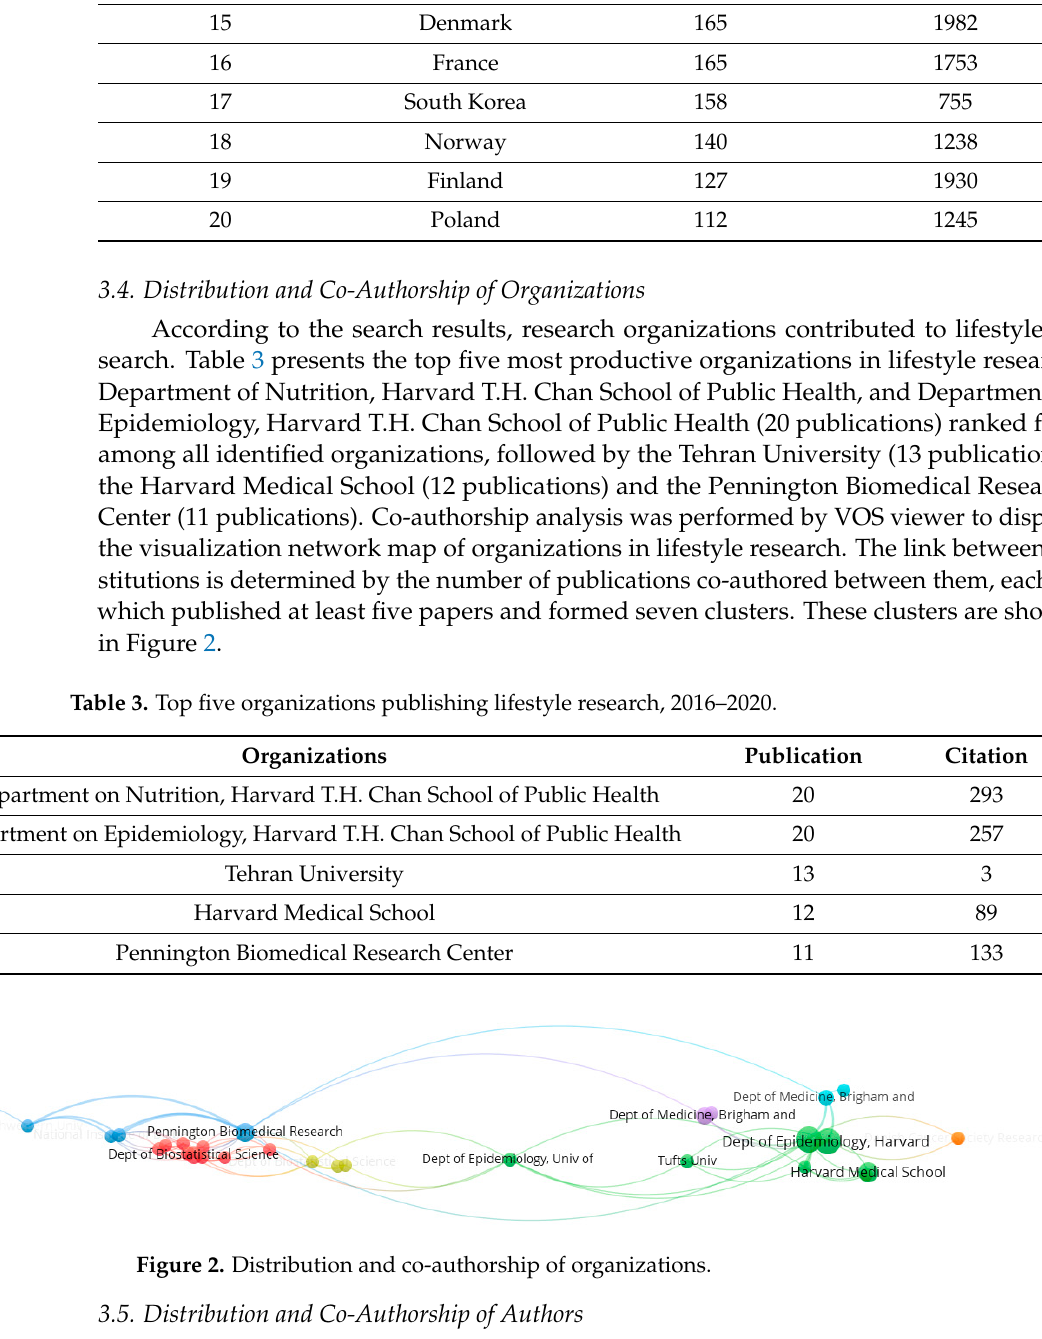
176 Figure 3. Distribution and co-authorship of authors.